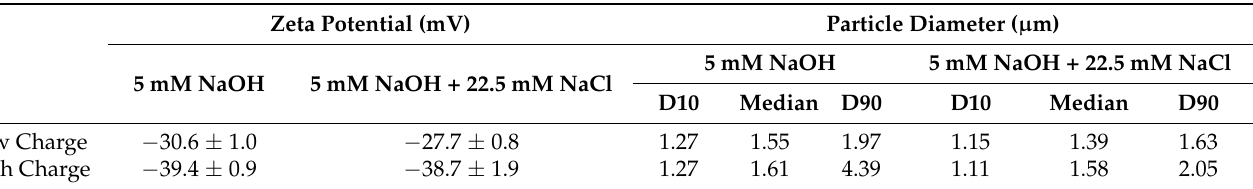
Table A1. Zeta potential and diameters (D10, median and D90 values) of low and high charge particles suspended in 5 mM NaOH and in 22.5 mM NaCl with 5 mM